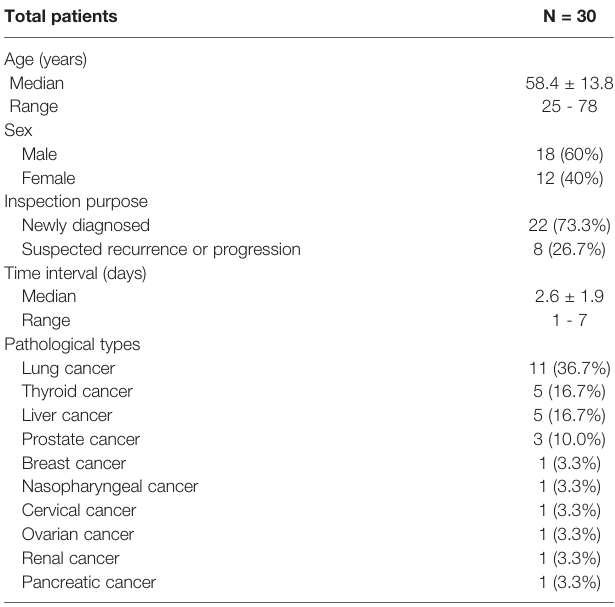
TABLE 1 | Characteristics of the 30 patients with bone